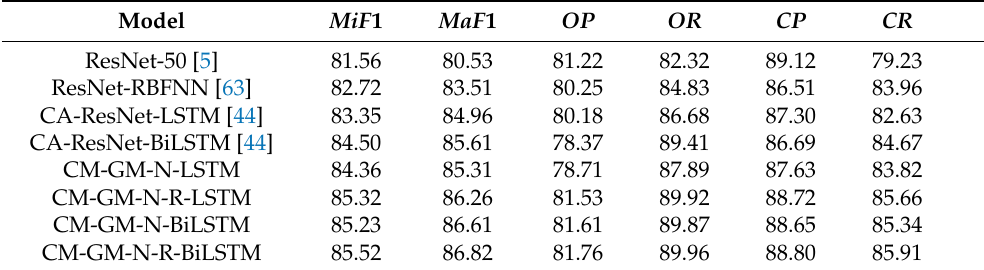
Table 2. The performance of different models on BigEarthNet.